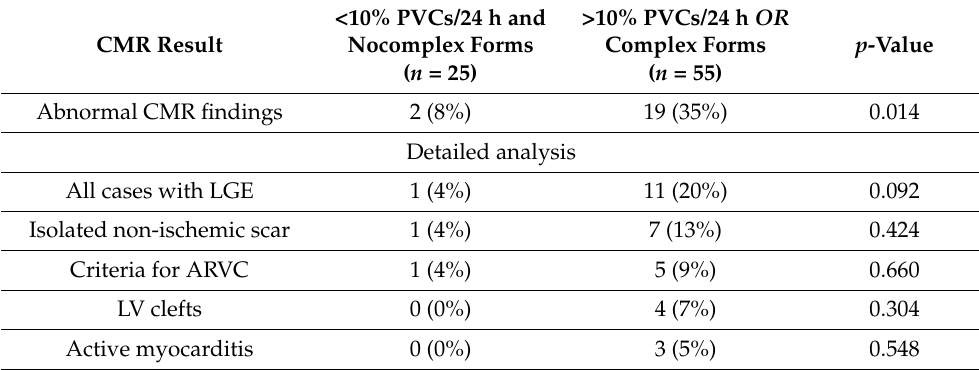
Table 4. Potential substrates of arrhythmia in children with ventricular ectopic beats in relation to the severity of